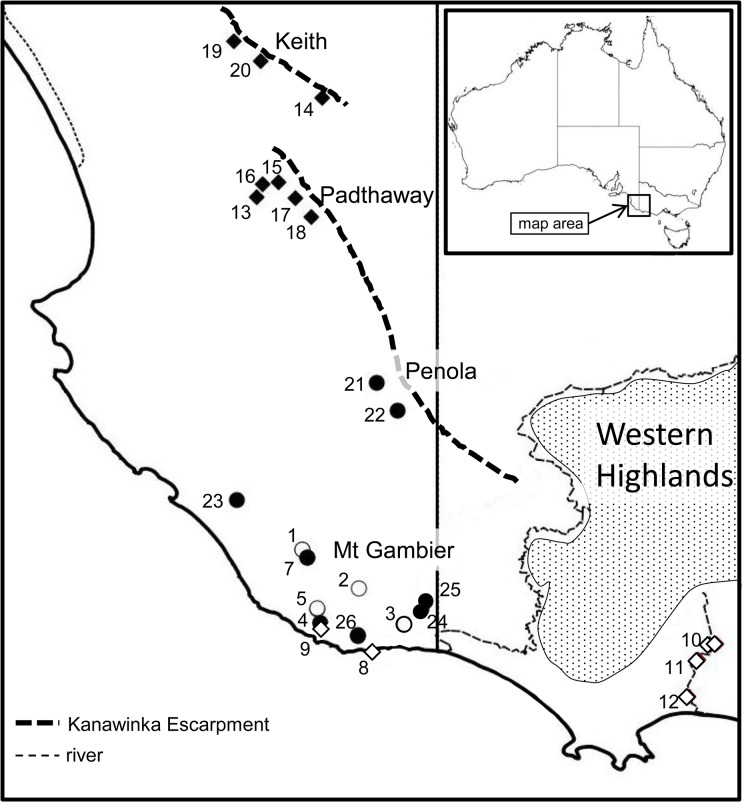
Map of the distribution of the Koonunga species treated in this paper.Locality numbers refer to data in Table 1. Open circle: K. crenarum; closed circles K. hornei sp. nov.; closed diamonds K. tatiaraensis sp. nov.; open diamonds K. allambiensis sp. nov..